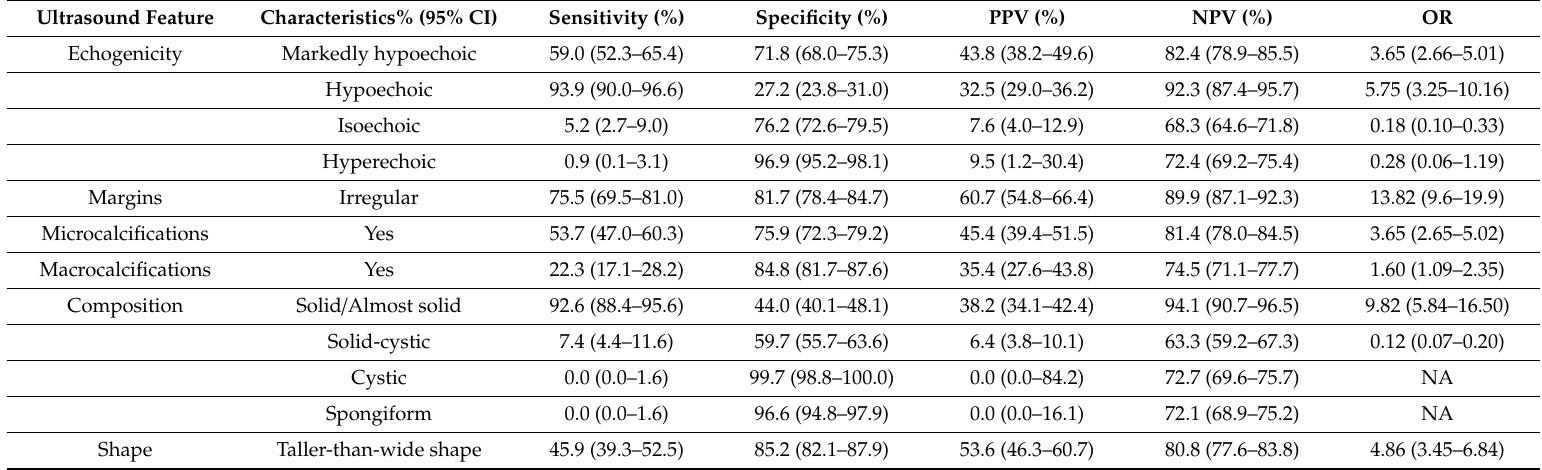
Table 3. Statistical analysis of B-mode parameters discriminating malignant from benign thyroid lesions (PPV—positive predictive value, NPV—negative predictive value, OR—odds ratio).